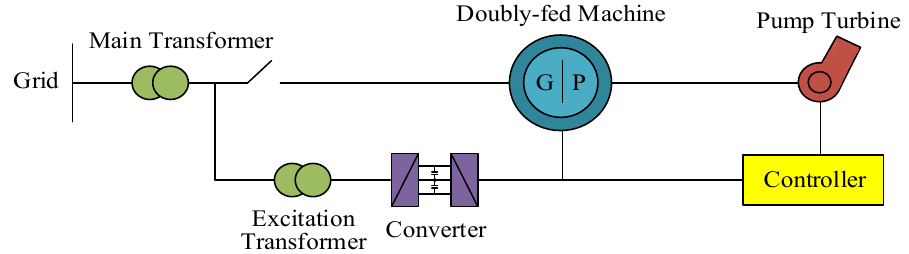
Figure 2. Structure diagram of the DFPSU.